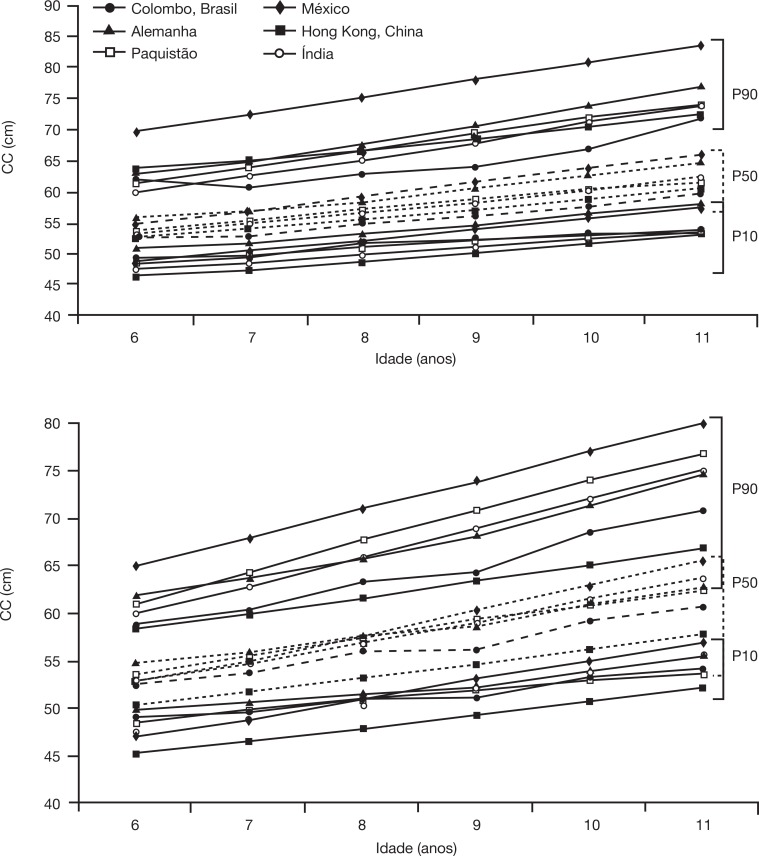
Comparação dos valores de percentis 10, 50, e 90 para circunferência da
cintura entre crianças de Colombo e crianças de outros países